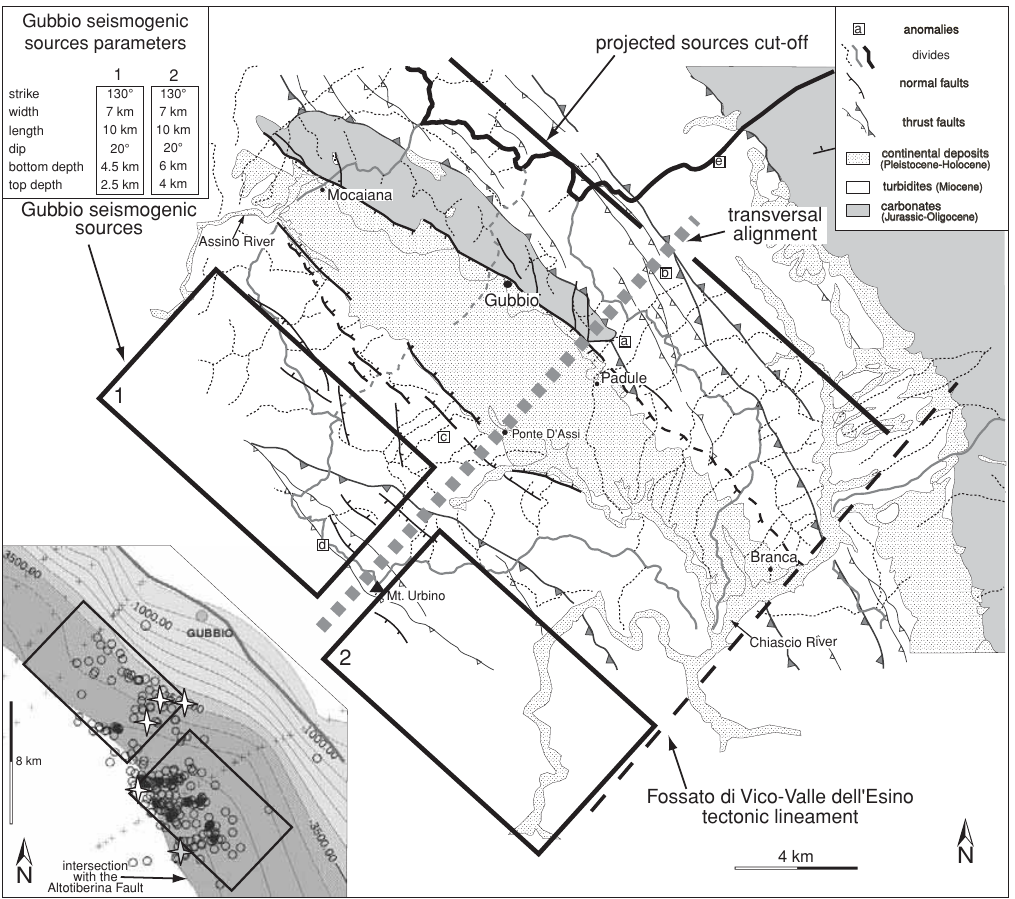
Fig. 16. Hypothesized seismic sources in the Gubbio area. Simplified geology and basin divides are reported. The thick normal faults are the high-angle sections of the Gubbio Fault System. The sources are represented as boxes, which are the projection of the low-angle plain of the Gubbio Fault to the surfaces. Dashed gray line is the hypothetical transversal lineament highlighted by structural and geomorphological anomalies. The inset shows the position of the sources with respect to the reconstruction of the Gubbio Fault isobaths, its intersection with the Altotiberina Fault and the 1984 seismicity (after Barchi et al. , 2000,